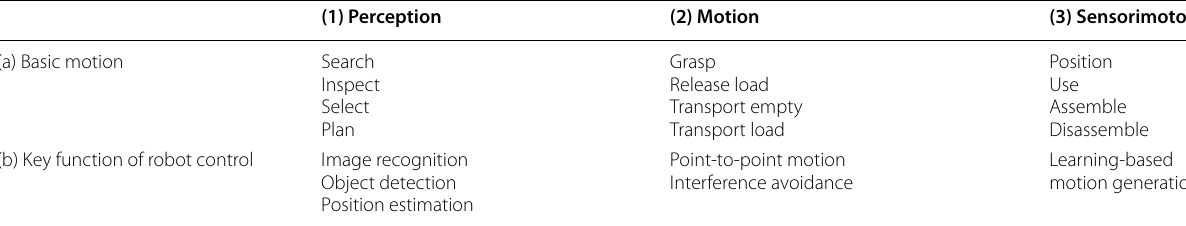
Table 1 Categorization of robot functions based on